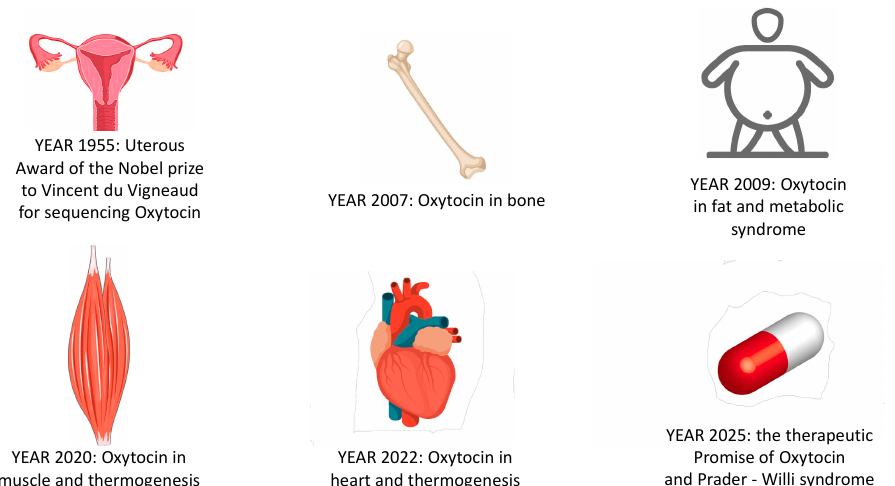
Figure 2. Seventy years of Oxytocin. This figure is a schematic representation of the groundbreaking discoveries of oxytocin’s functions over the past 70 years. In 1957, oxytocin was first sequenced, and its function as a uterotonic was established [8]. In 2007, oxytocin and oxytocin receptors were sequenced in osteoblasts, osteoclasts, and stem cells [22]. In 2009, oxytocin deficiency was unequivocally linked to fat and metabolic syndrome but in the absence of hyperphagia [35,36]. In 2016, oxytocin was found in muscle cells [2]. In 2020, oxytocin was shown to mediate thermoregulation and muscle contraction [3]. In 2022, a new pathway of oxytocin merging muscle, thermoregulation, myocardium functionality, and metabolism was discovered [4]. In 2025, it is estimated that oxytocin will be involved in Prader–Willi syndrome etiology, with anti-obesity properties [77,79]. Funding: This research was supported by the grant “Ateneo 2017” from the University of Bari “Aldo Moro” to Prof. Claudia Camerino.